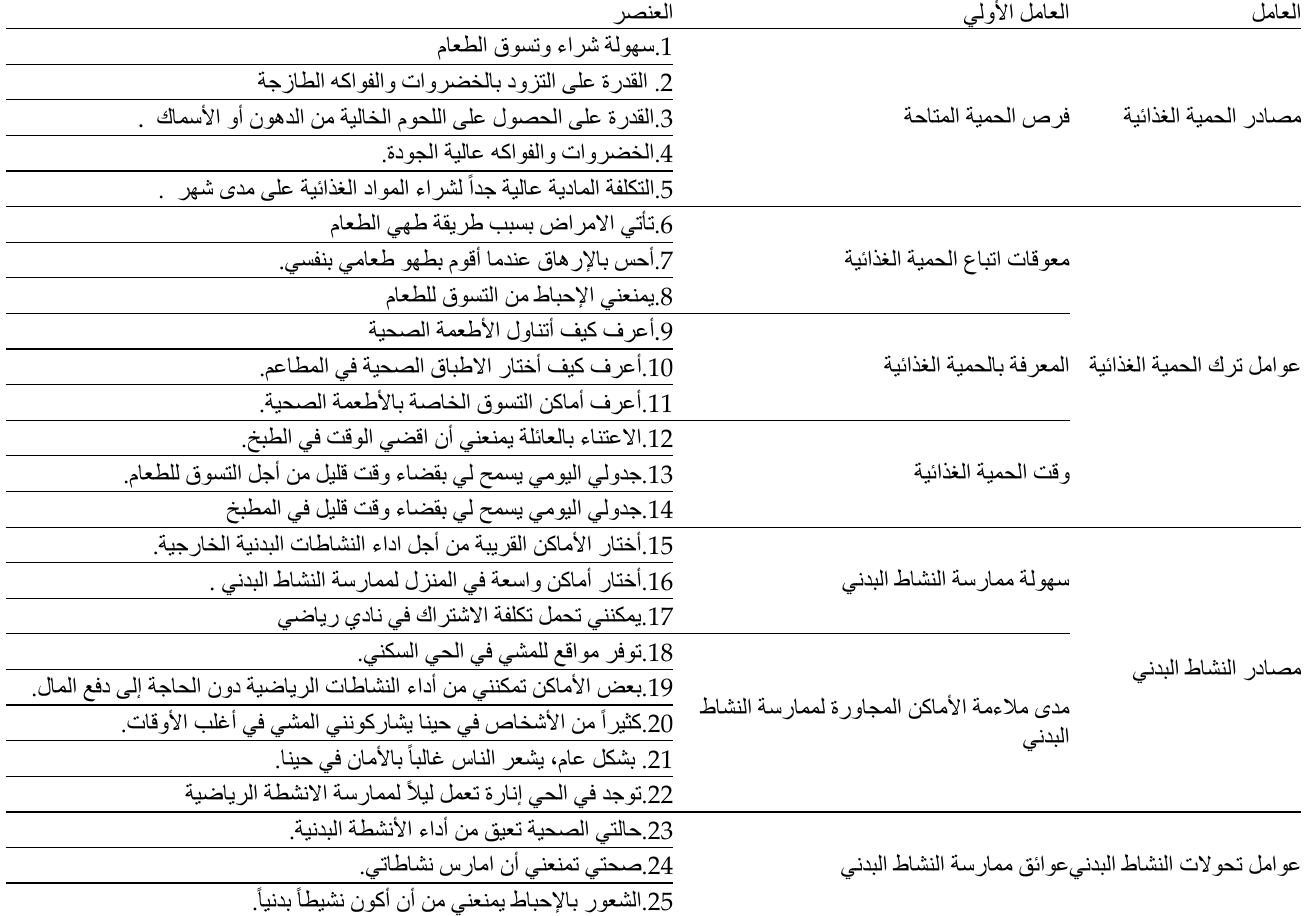
Table A1. The Arabic Version of the Capability Assessment for Diet and Activity (CADA) Questionnaire.